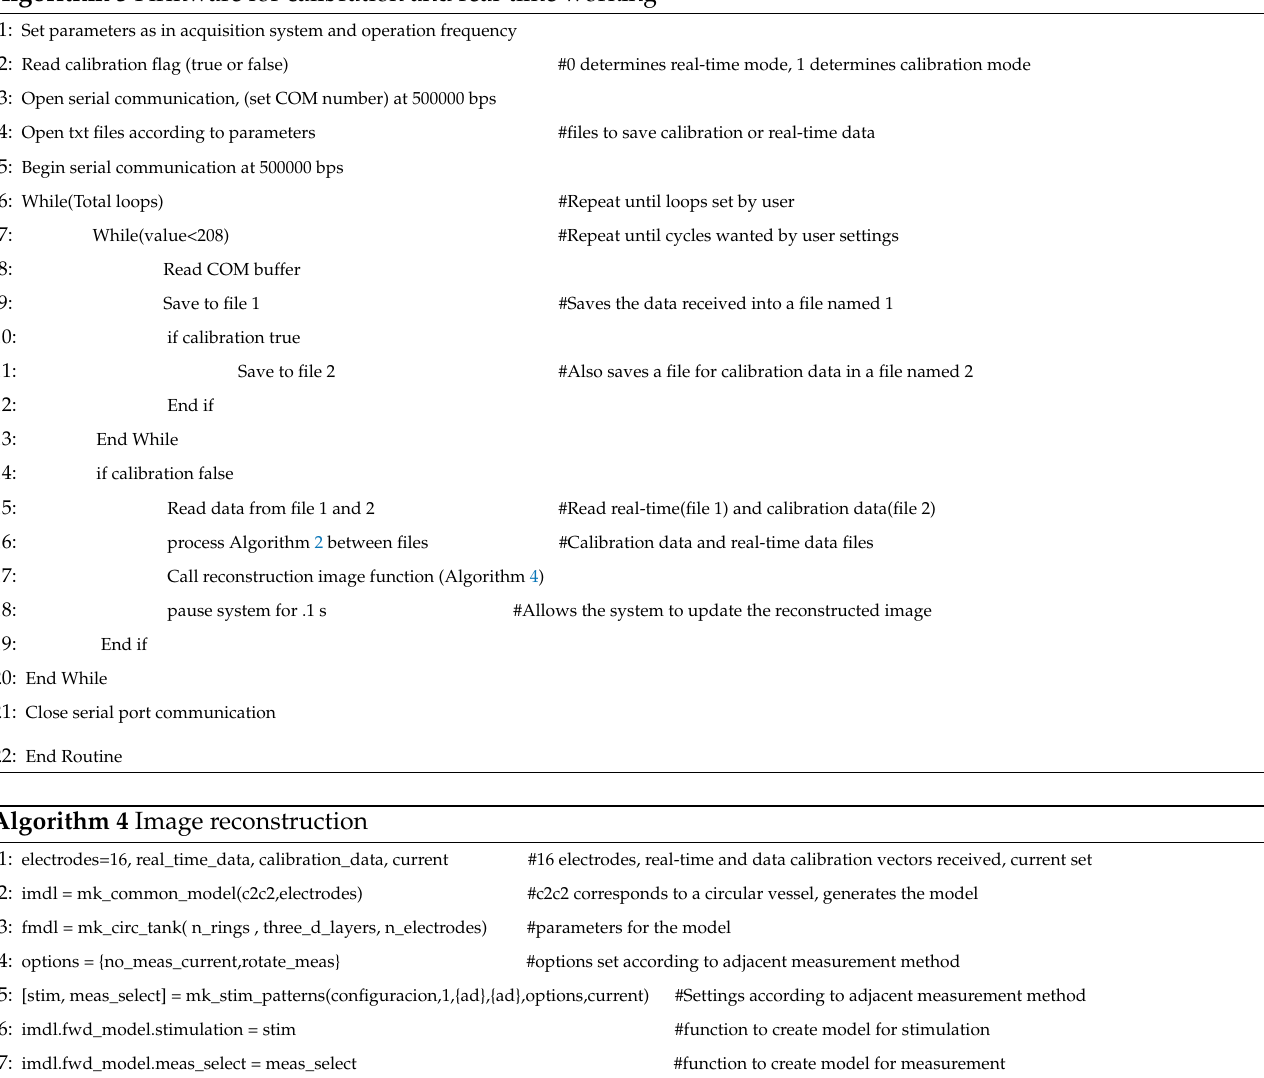
Algorithm 3 Firmware for calibration and real-time working